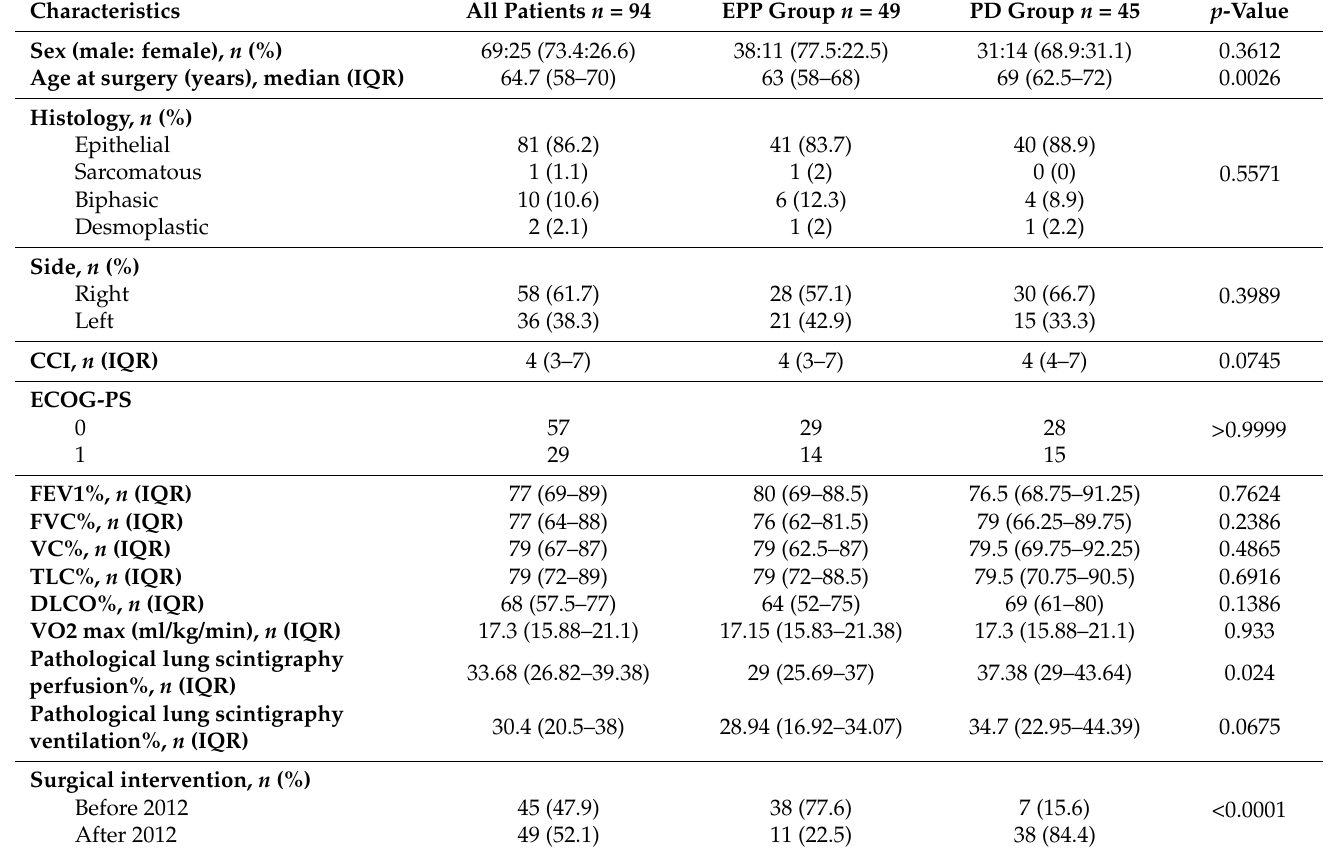
Table 1. Characteristic of patients ( n =